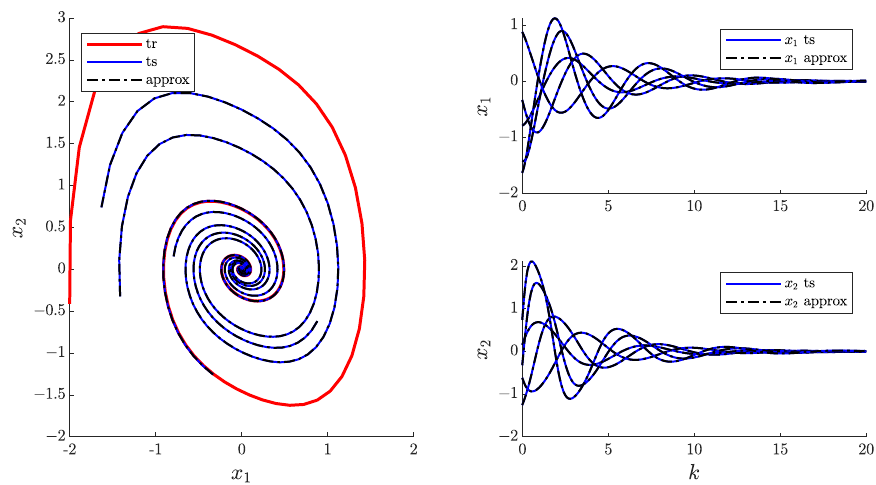
Figure 2. EDMD approximation of the hard damping Duffing